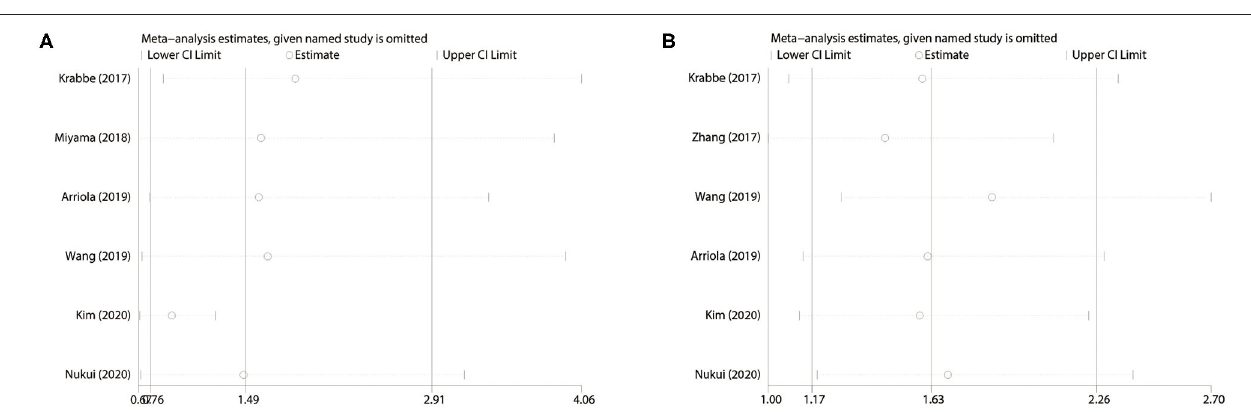
FIGURE 6 | Sensitivity analysis. (A) PD-L1 for OS; (B) PD-L1 for CSS. OS, overall survival; CSS, cancer-specific survival.